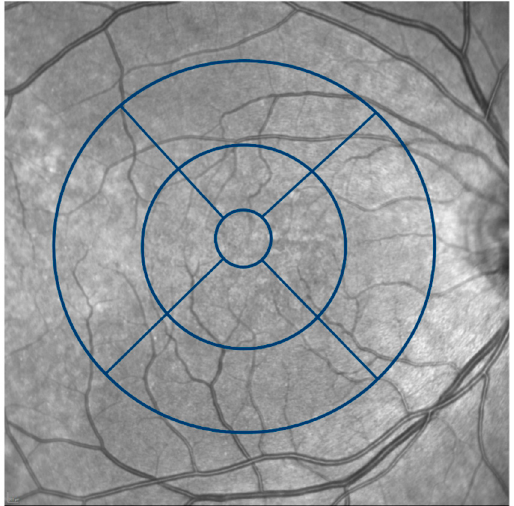
Figure 2. Grid for retinal layer thickness measurement. Retinal layer thickness was measured according to the ETDRS grid that was divided into a central area including the fovea with a diameter of 1mm, an inner ring with a diameter of 3mm, and an outer ring with 6 mm.